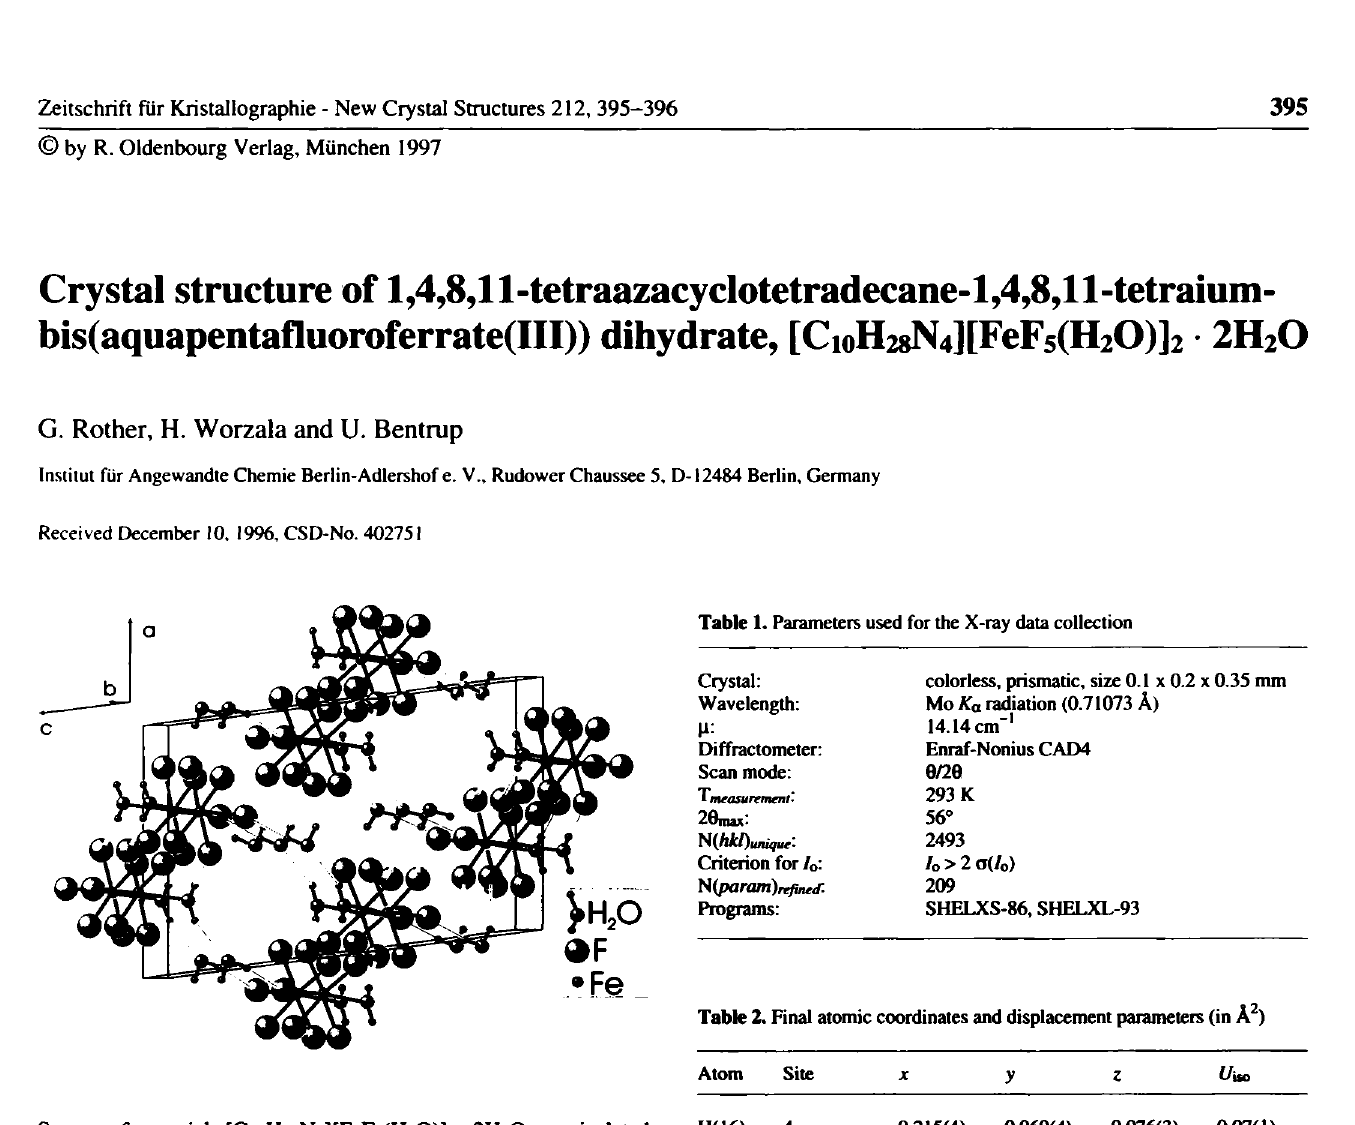
Table 2. Final atomic coordinates and displacement parameters (in Â 2 )